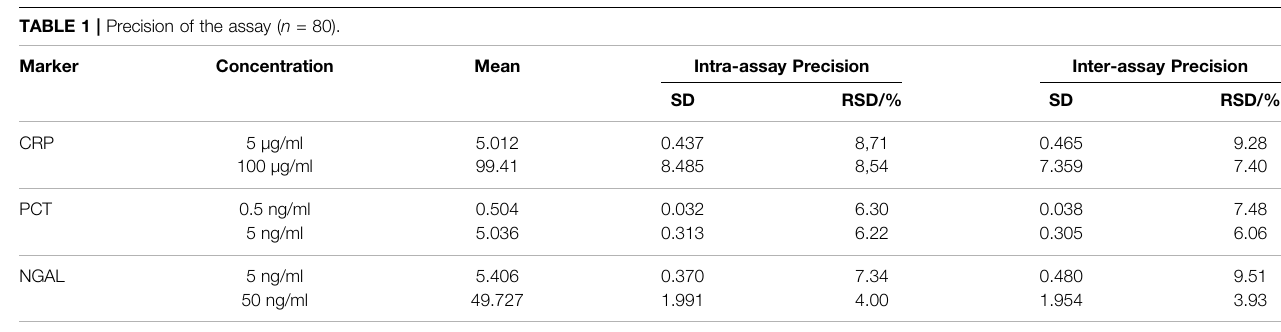
TABLE 1 | Precision of the assay ( n =